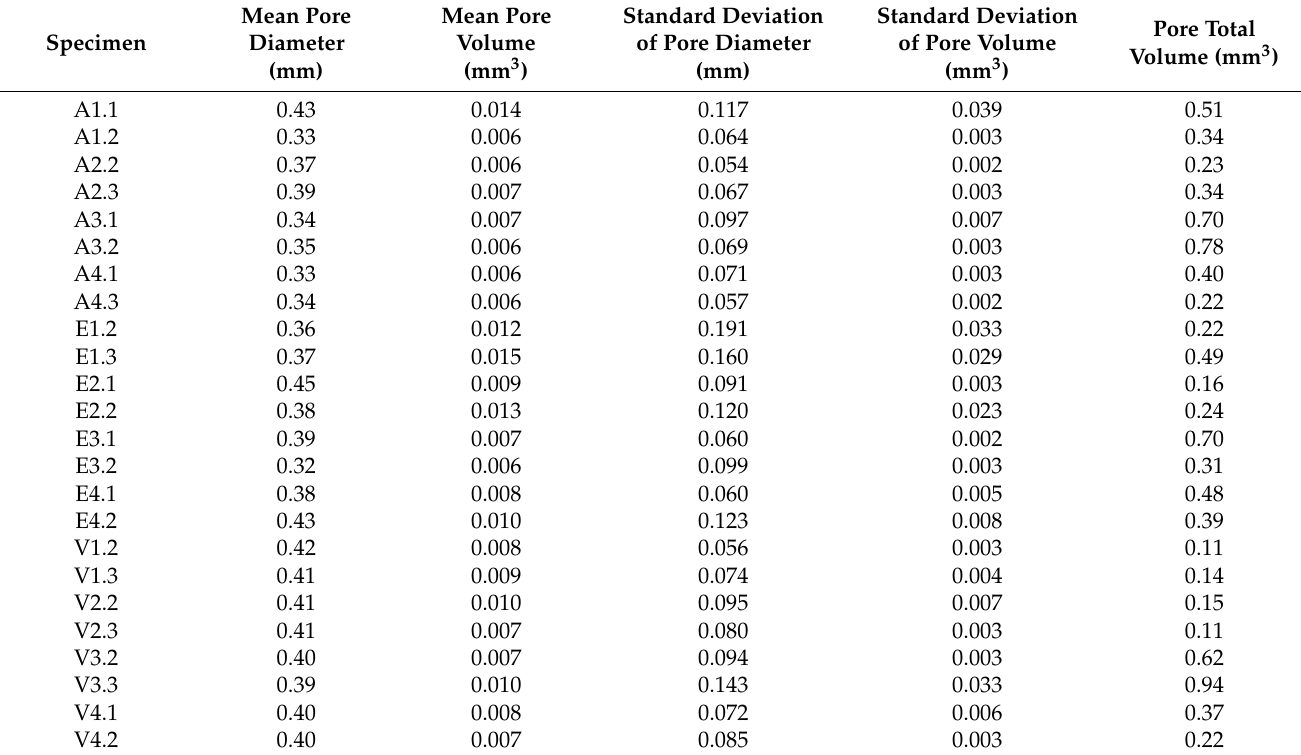
Table 5. Results of tomography measurements of tensile testing specimens.